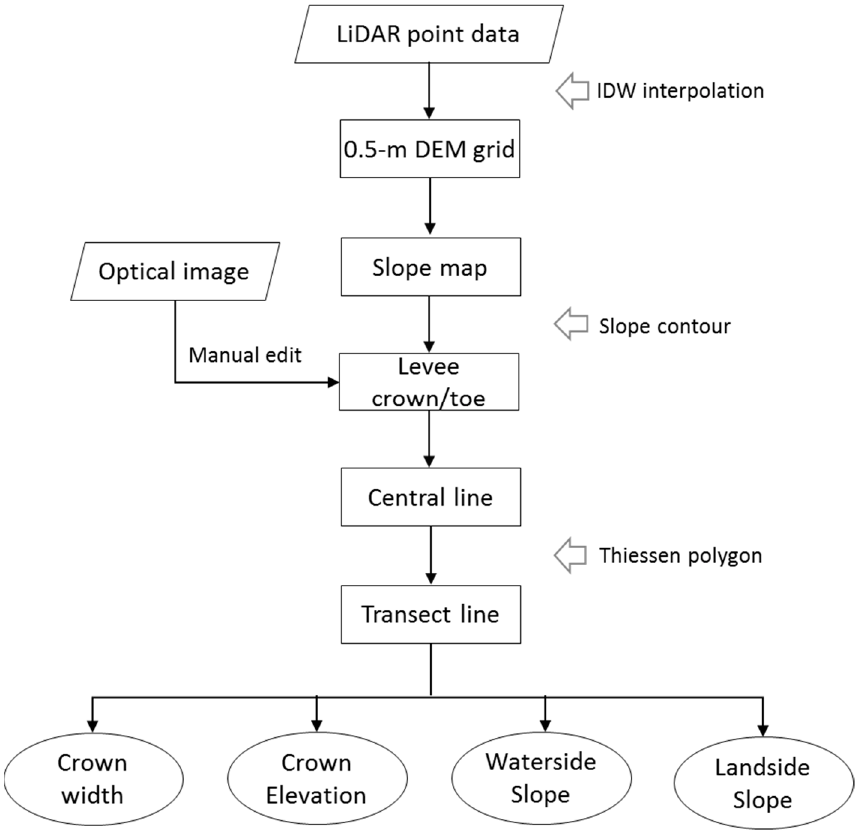
Figure 3. The flowchart and main methods used in extraction of levee geometric parameters.